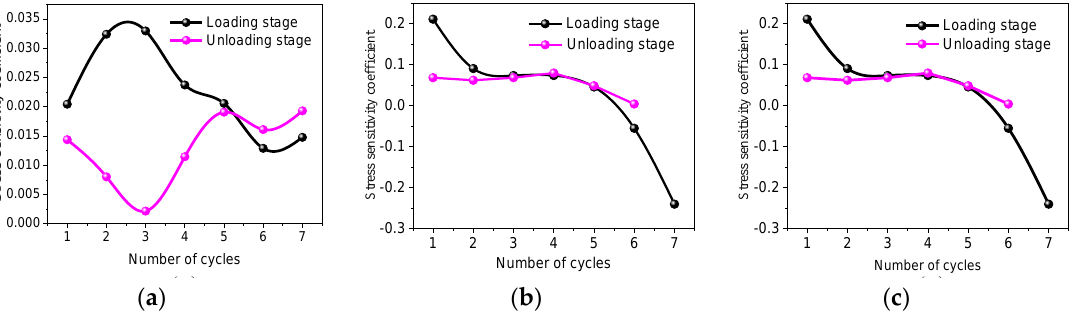
Figure 16. The changes in the stress sensitivity coefficient of the permeability of coal samples under different cyclic loading–unloading paths. ( a ) Stress path 1. ( b ) Stress path 2. ( c ) Stress path 3.